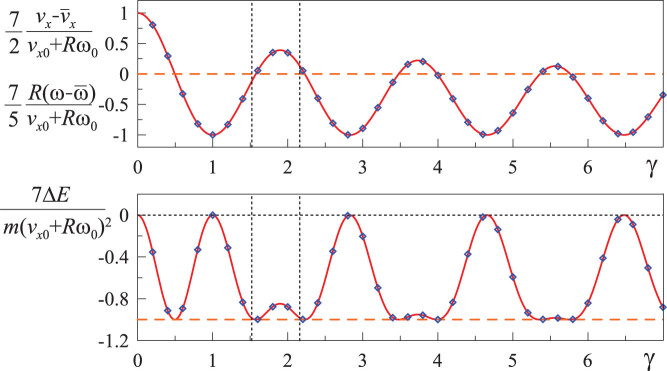
Dependencies of the variables , , and  on the parameter .The impacts were calculated for various initial conditions, various radii, elastic moduli and masses of the spheres. Independently of the parameters used, all data collapse to a master curve, which determines unambiguously the rebound values of the kinematic variables as a function of the incident values. The classical, rigid-body solution (5), (6) is shown by the horizontal dashed line. The interval (28) is shown by vertical dotted lines.